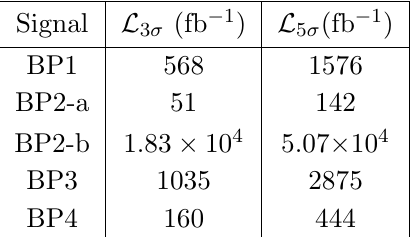
(cid:12)nal states at T